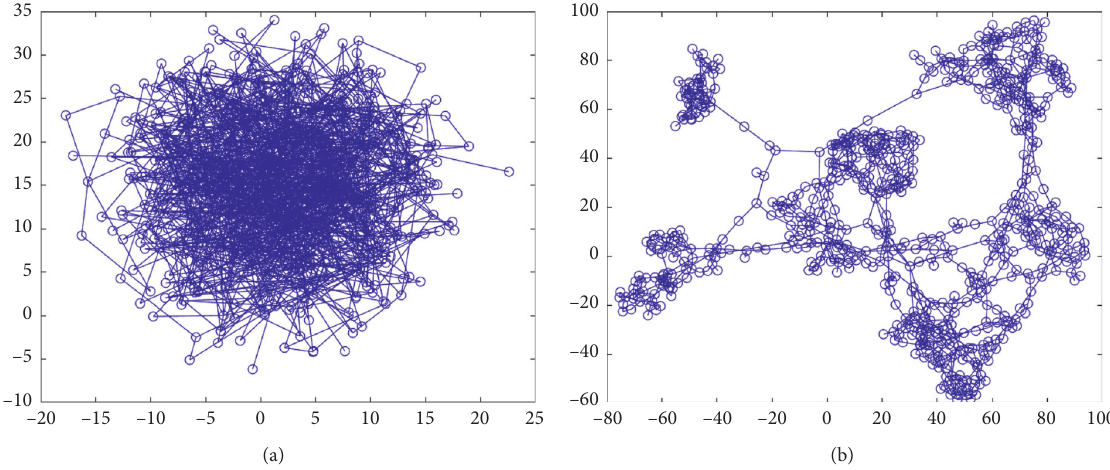
Figure 9: Production data visualization based on the cloud platform. (a) Before processing and (b) after